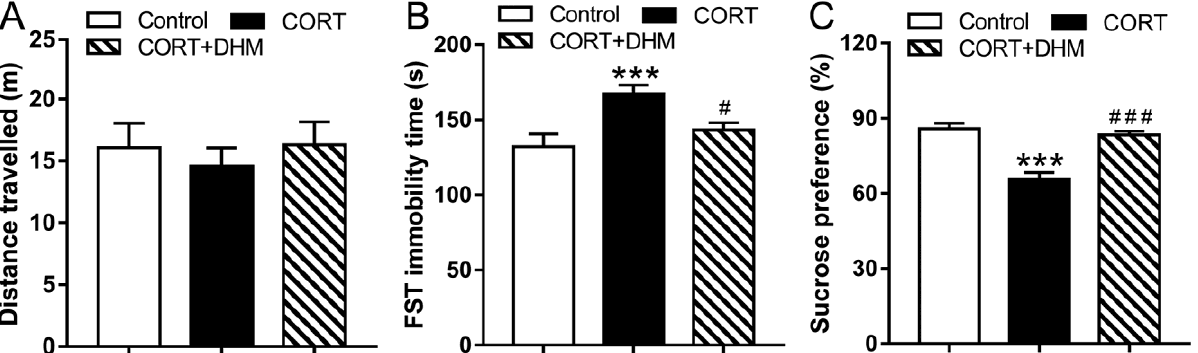
Figure 2. Effect of DHM administration on depression-like behaviors induced by CORT in mice. ( A ) Total distance travelled by the three groups in the open field test (OFT) (n = 10). ( B ) Immobility time of the three groups in the forced swimming test (FST) (n = 10). ( C ) Sucrose preference of the three groups in the sucrose preference test (SPT) (n = 5). Data are expressed as mean ± SEM; *** p < 0.001, vs. the control group; # p < 0.05, ### p < 0.001, vs. the CORT group. CORT, corticosterone; DHM, dihy- dromyricetin.